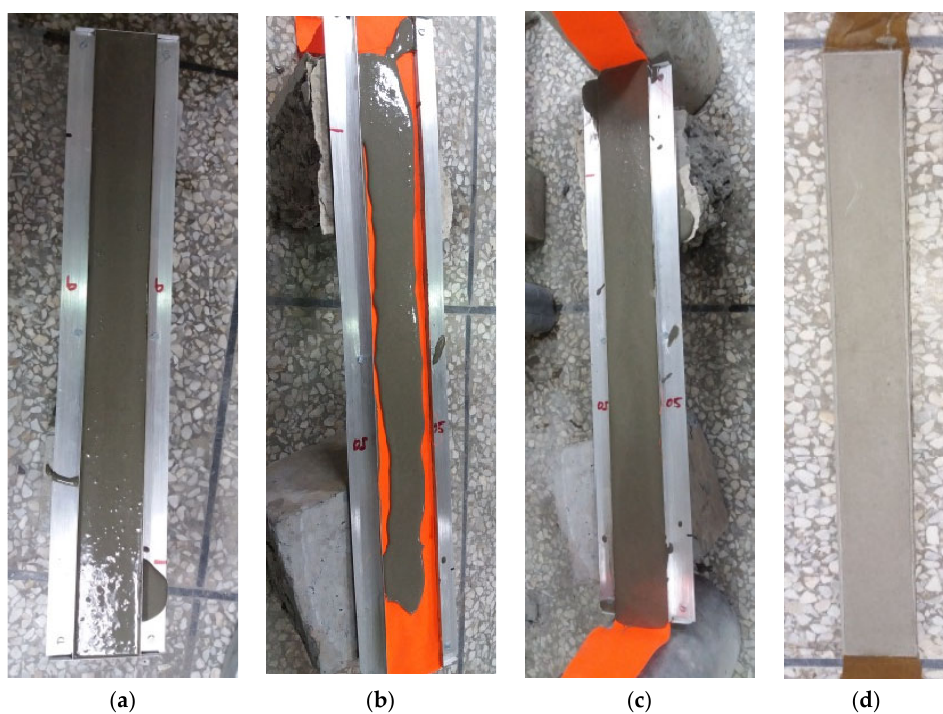
Figure 6. Casting of textile ‐ reinforced mortar specimens ( a ) first layer of mortar, ( b ) placement of fabric strip, ( c ) second layer of mortar, ( d ) de ‐ molded specimen.